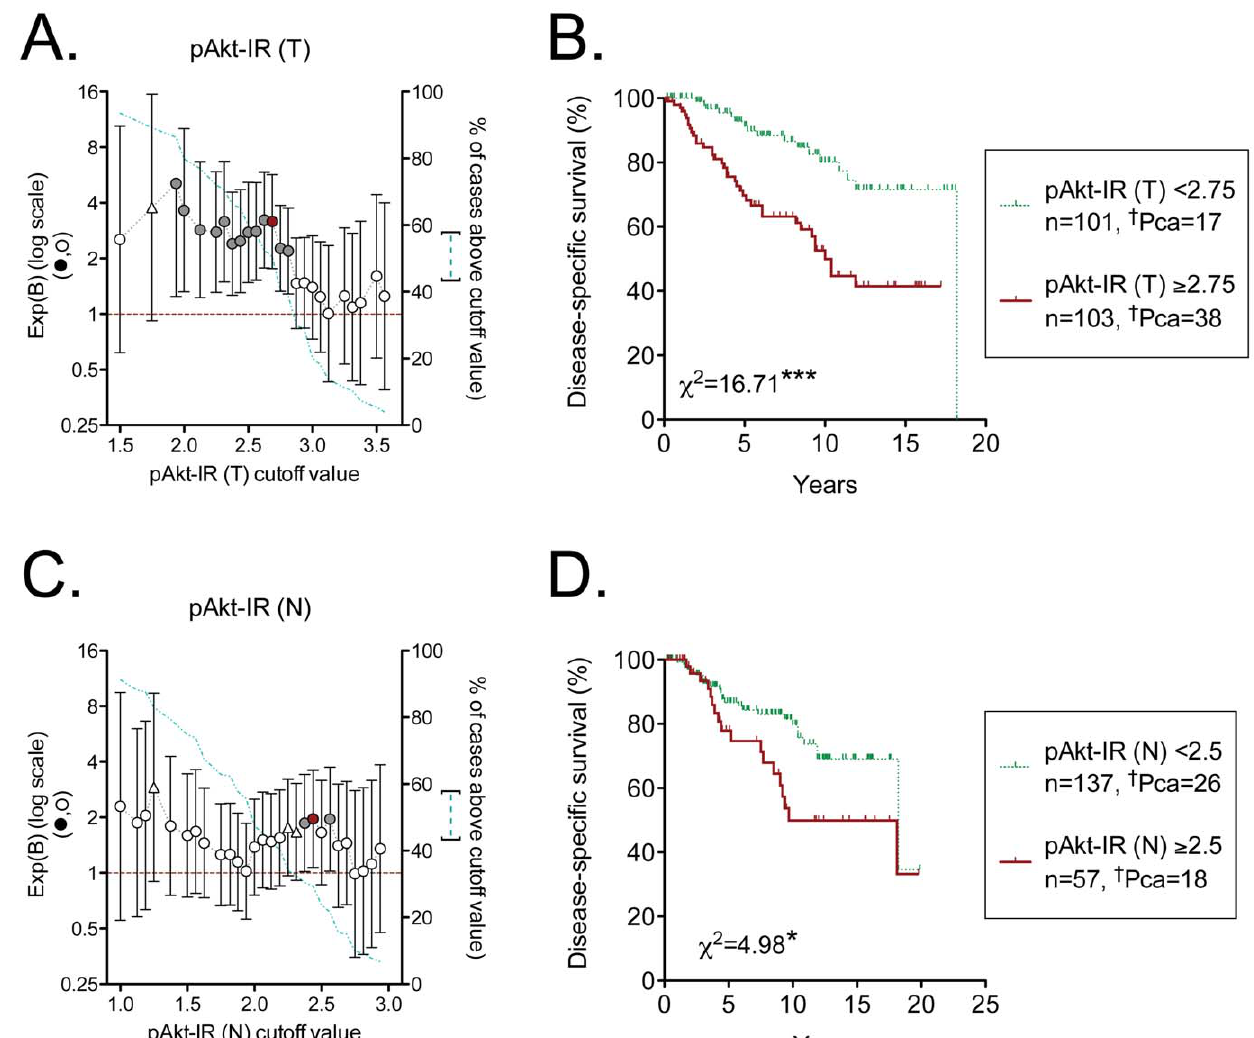
Figure 2. Prognostic significance of tumour and non-malignant pAkt-IR for cases who were followed by expectancy. Panels A and B are for tumour pAkt-IR (n=204), C and D for non-malignant pAkt-IR (n=194). In Panels A and C, Exp(B) ( 6 95% confidence intervals), obtained from Cox proportional-hazards regression analyses are shown for different cut-offs. Exp(B) is defined as the increase in risk for death due to prostate cancer for a score above the cut-off value relative to a score below the cut-off value. When both confidence limits are above unity (filled symbols in the figure), the cut-off value provides significant prognostic information. Values with a significance level 0.05 , P , 0.1 are shown as open triangles. The cut-off value with the highest significance is shown as a red filled symbol. The blue dotted line indicates the % of cases above the cut-off value. Thus, for example, for the symbol in Panel A at pAkt-IR cut-off value 2.5 (i.e sample divided as # 2.5 and . 2.5), 82 cases (40%) were # the cut-off value and 122 cases (60%) above the cut-off value. In Panels B and D, Kaplan-Meier plots are shown for the cut-offs showing the highest significances. { Pca refers to the number of patients who died as a result of their prostate cancer during the follow-up period. The k¸ 2 values are for the log-rank (Mantel- Cox) tests, with the P values shown: ***P , 0.001, *P , 0.05.